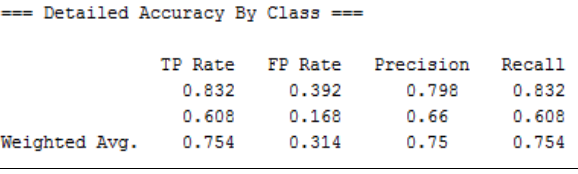
Figure 12. Diagnosis of diabetes using artificial neural network.